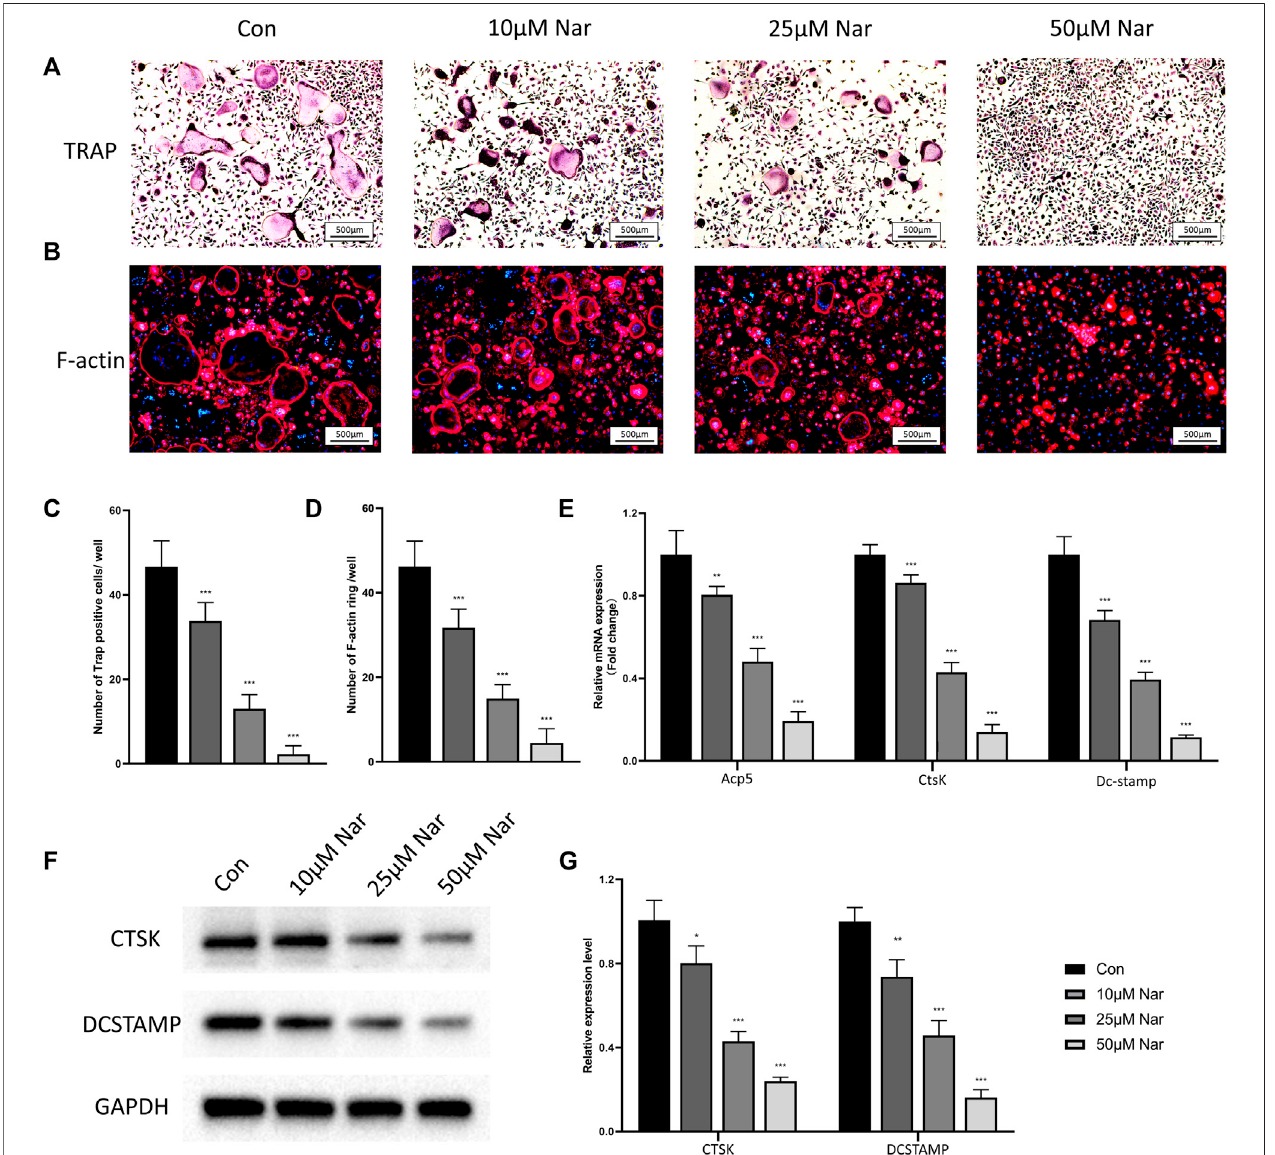
FIGURE 2 | Naringenin inhibits osteoclastogenic differentiation of BMMs. (A,C) Formation of TRAP-positive cells and its quanti fi cation. (B,D) Formation of F-actin rings and its quanti fi cation. (E) Transcript levels of osteoclast markers acid phosphatase 5, tartrate resistant (Acp5), cathepsin K (CtsK) and dendritic cell-speci fi c transmembrane protein (Dc-stamp). (F,G) Western blot and optical density analysis of CTSK and DCSTAMP with GAPDH as reference. n = 4 per group. Data are expressed as mean ± SD. * p < 0.05; ** p < 0.01; *** p < 0.001. * compared with con group.